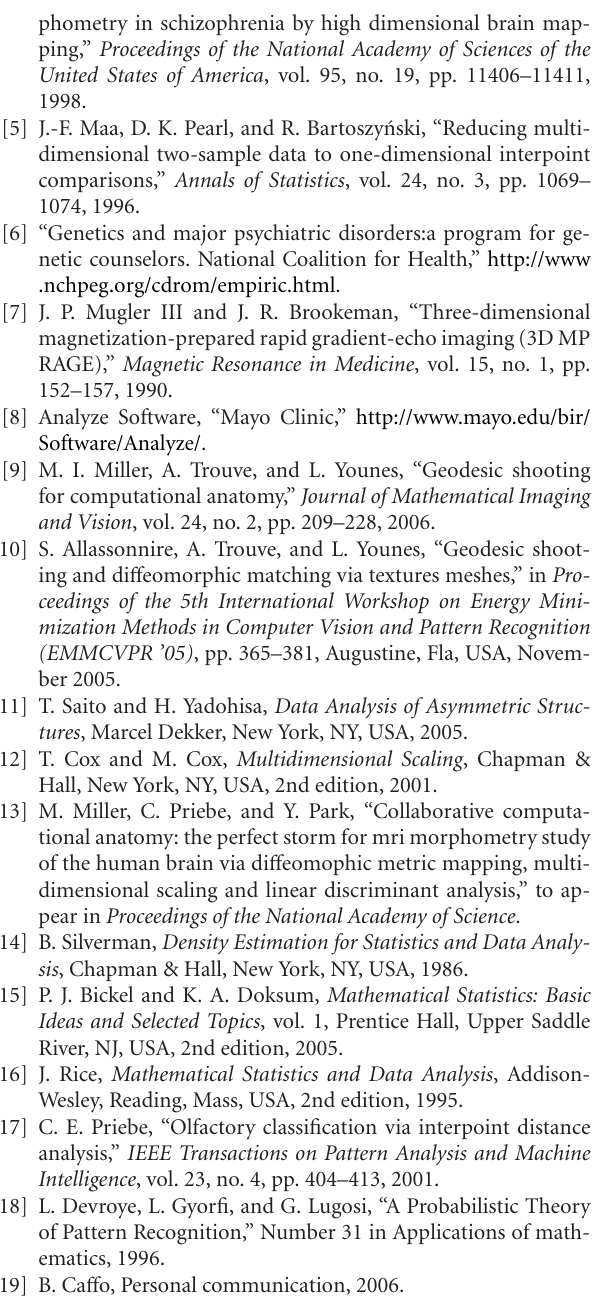
class, conditionally on “training” data from MDD and